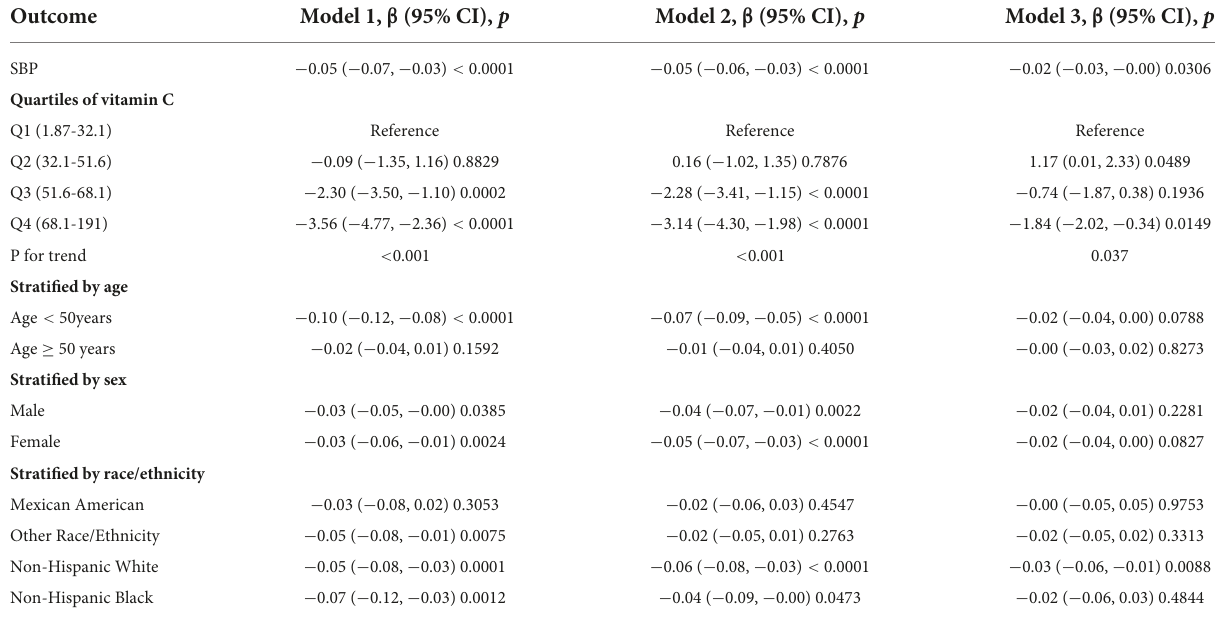
TABLE 2 Association between serum vitamin C (umol/L) and SBP (mmHg).